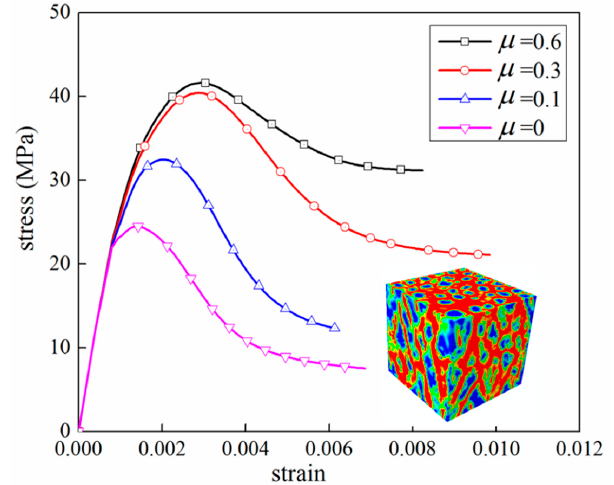
Figure 21. Comparison of different frictional coefficients under compression.